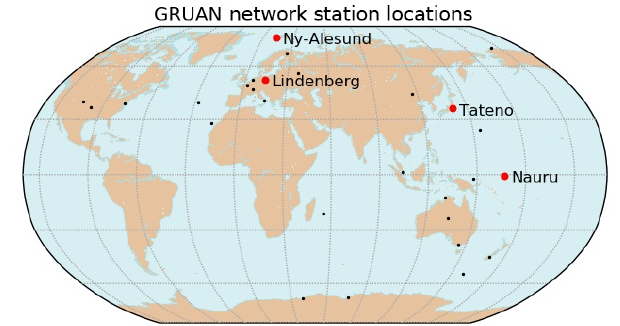
Figure 1. Map of the GRUAN RS network. Labeled locations with red dots are RS stations used in this study, and black dots mark the other GRUAN network RS stations. For more information about these and other GRUAN stations, see https://www.gruan.org (last access: 25 April